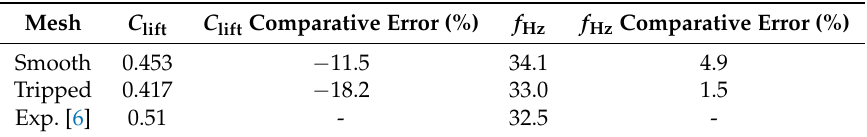
Figure 6. Variation of lift coefficient in the cavitating flow conditions. Table 3. Comparison of the shedding frequency and the time averaged Lift coefficient for the smooth and tripped